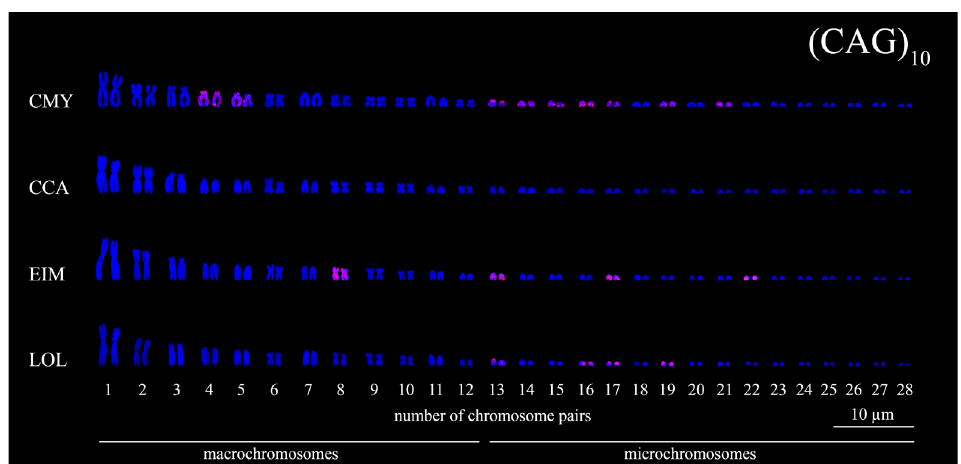
Figure 6 – Karyotypes of sea turtle species subjected to FISH using (CAG) their 3-letter acronym: C. mydas (CMY), C. caretta (CCA), E. imbricata (EIM) and L. olivacea